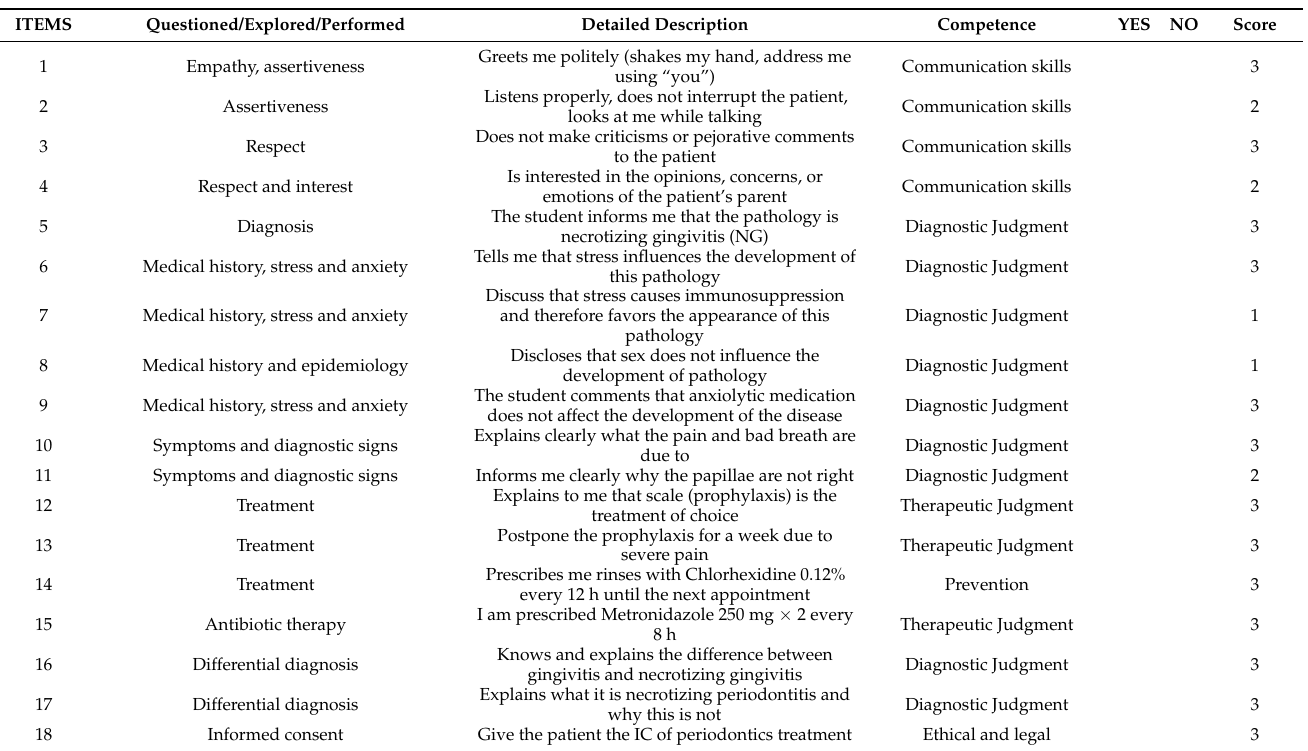
Table 1. Station evaluated items